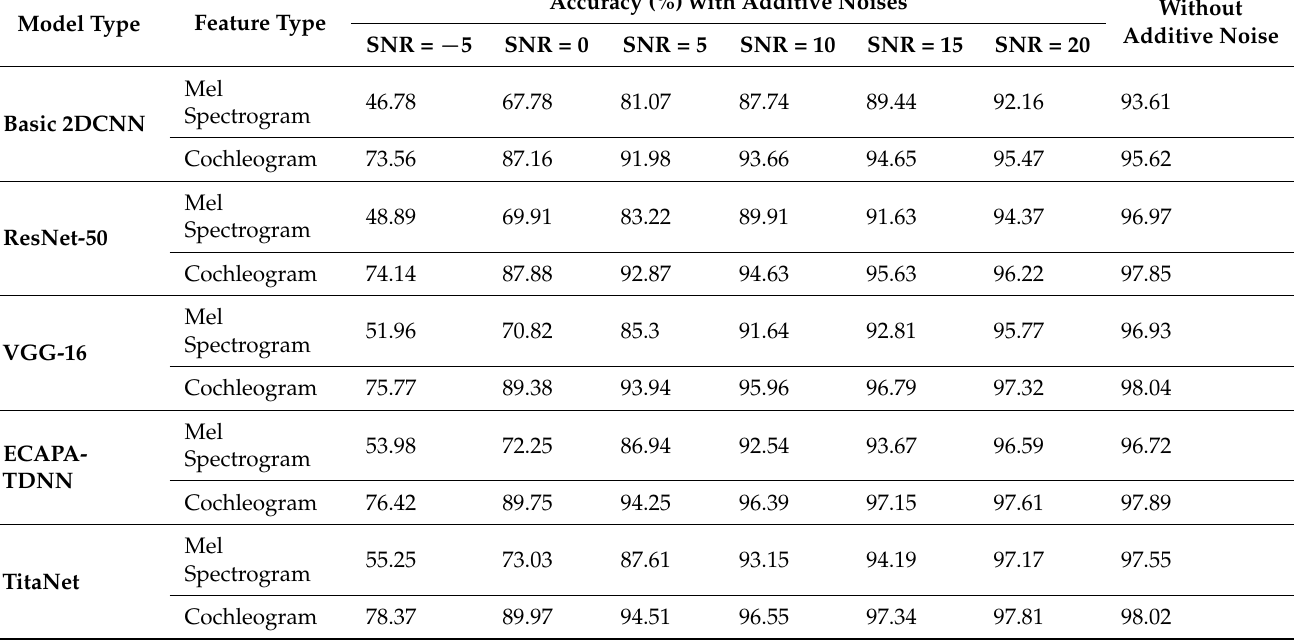
Table 5. Speaker Identification Performance of the Cochleogram vs. Mel Spectrogram with and without additive noises on